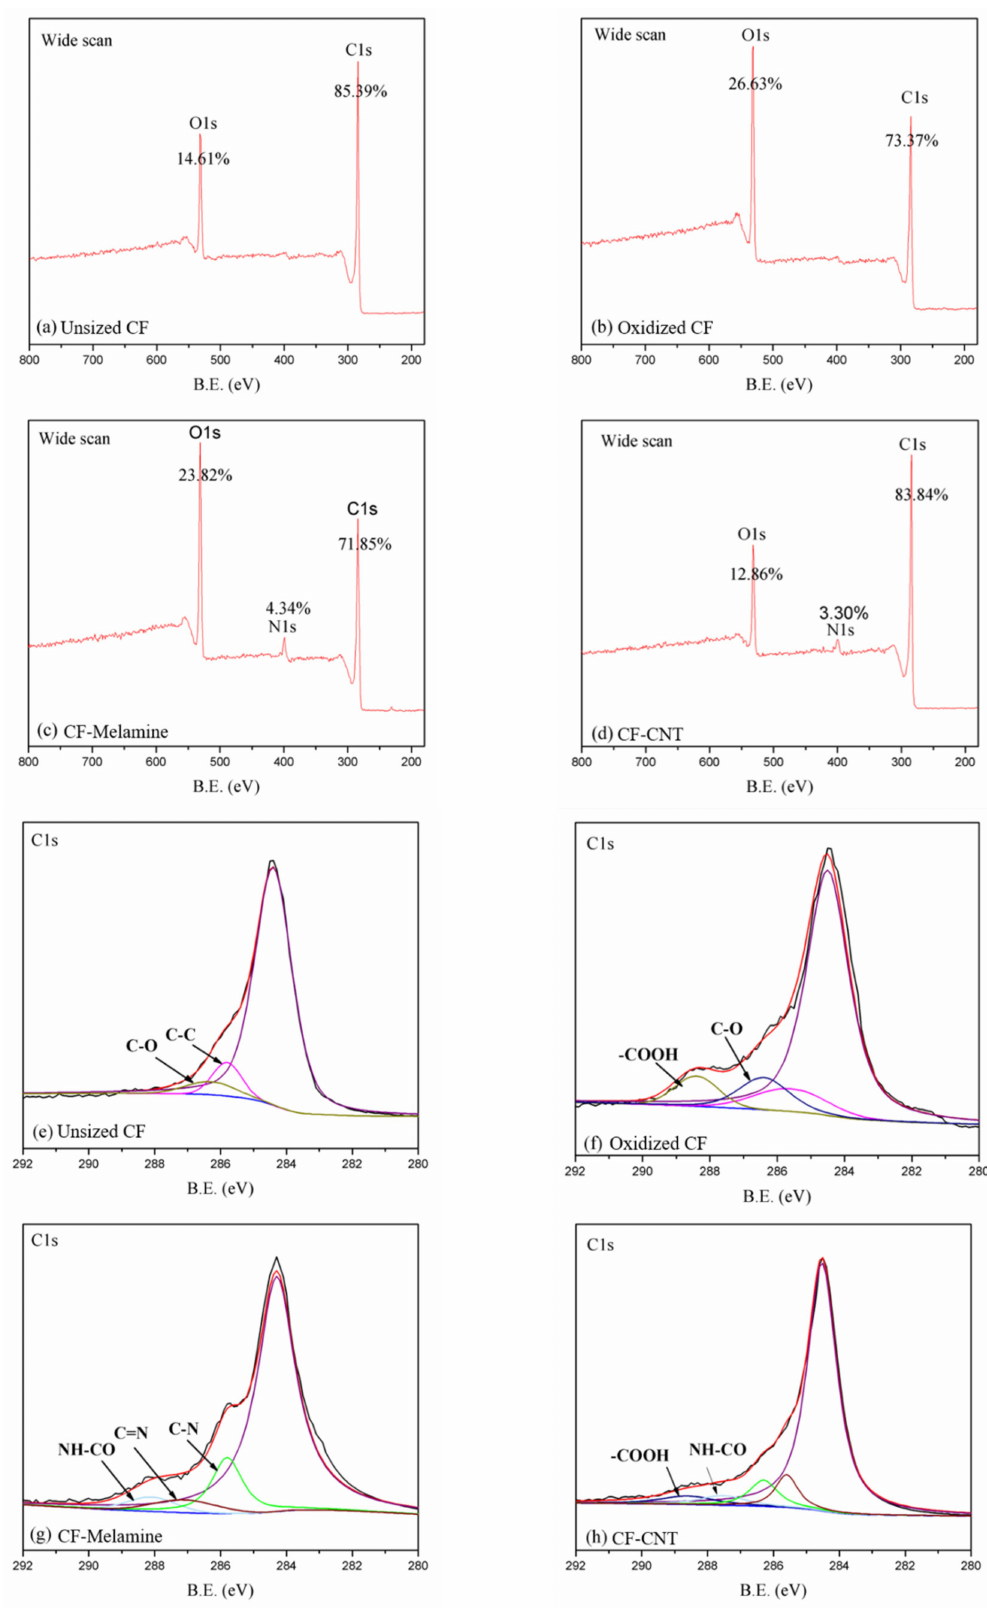
Figure 2. Wide-scan XPS spectra and C1s high-resolution XPS elemental spectra of ( a , e ) Unsized carbon fiber, ( b , f ) oxidized carbon fiber, ( c , g ) CF-Melamine, and ( d , h ) CF-CNT. (For interpretation of the references to color in this figure legend, the reader is referred to the web version of this